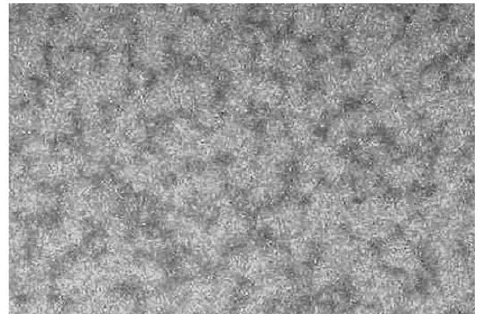
Figure 1. A (contrast-enhanced) conventional photographic image, with illumination from the bottom, of a 4 × 6 cm portion of a Petri plate used for preparative propagation of phage T4 in-gel (plate stock). Propagation was for 17 h. The light regions (plaques) are completely clear to the eye.